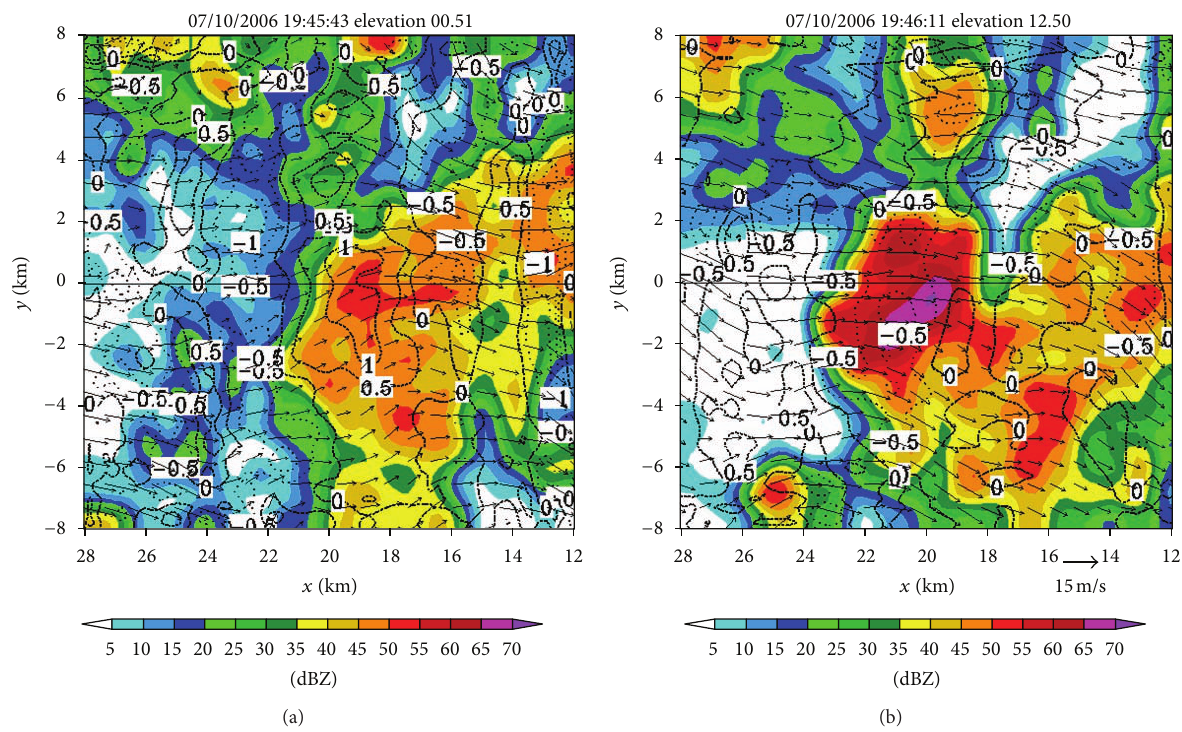
Figure 8: As in Figure 4 but the retrieved (𝑢 𝑚 , V 𝑚 ) fields are from the first step of Expt-5min on the conical surfaces of (a) 𝜃 = 0.51 ∘ and (b) 12.50 ∘ at the same times (19: 45 :43 and 19 :46 :11 UTC) as those in Figures 4(a) and 4(e), respectively.